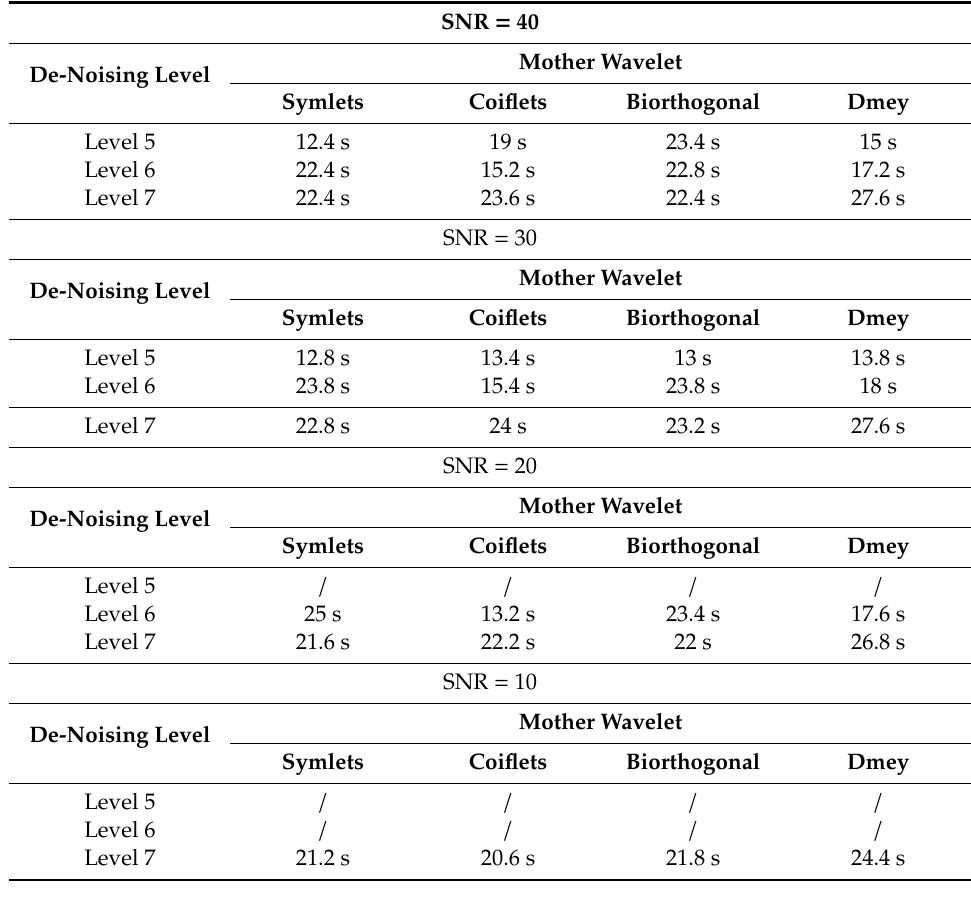
Table 3. Travel times t peak for di ff erent mother wavelet types and de-noising